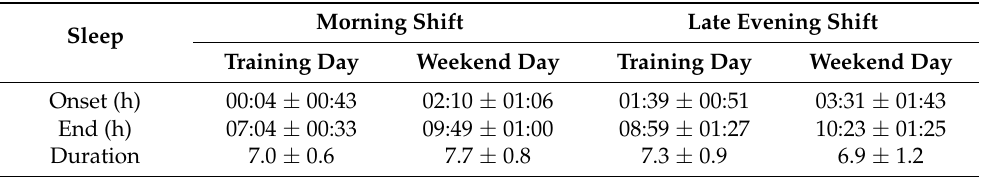
Figure 1. Sleep pattern by type of day and training shift. Sleep schedule on weekend days and training days in dancers attending either the morning (orange bars, 08:30 to 12:30, n = 15) or the late evening training shift (blue bars, 20:00 to 24:00, n = 16). Each rectangle extends from the grand mean sleep onset to the grand mean sleep end. Lines represent standard deviation. Table 1. Sleep pattern grand mean values by type of day and training shift. Sleep schedule on weekend days and training days in students attending either the morning (08:30 to 12:30, n = 15) or the late evening training shift (20:00 to 24:00, n = 16).